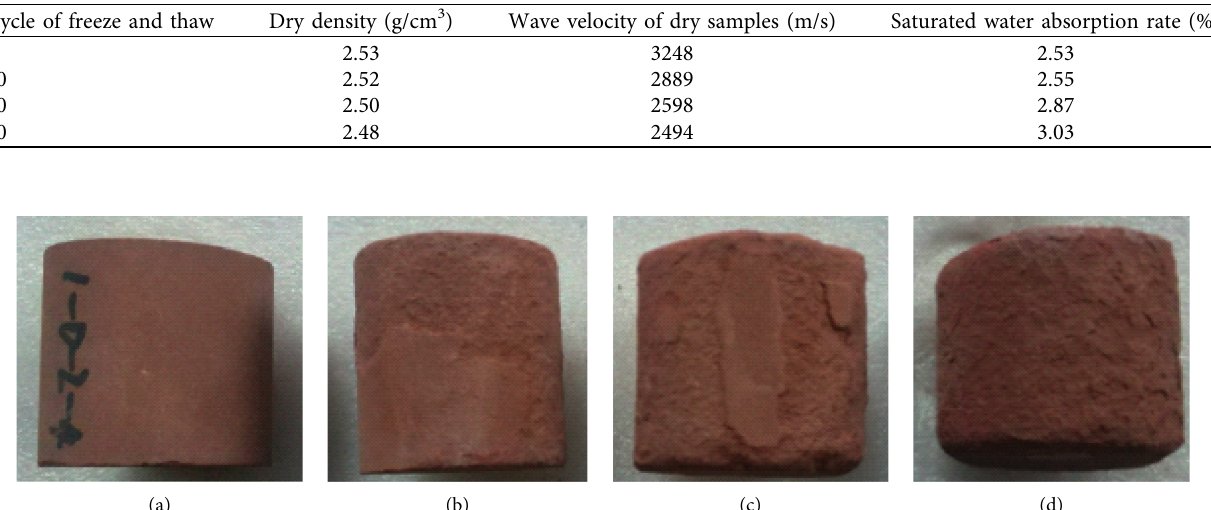
Table 1: Physical indexes of samples with different freeze and thaw cycles.